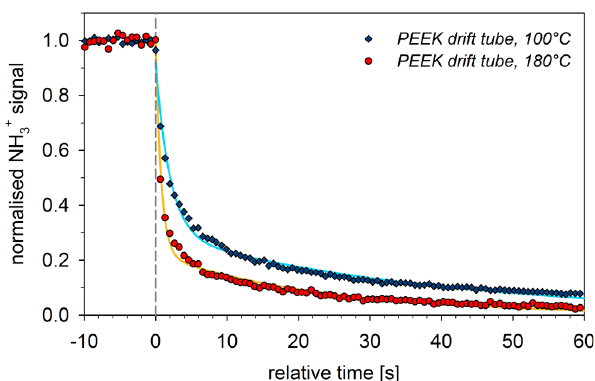
Fig. 4. Improvement of HT-CIMS time response by heating of the new prototype PEEK drift tube: switch from ∼ 150ppb to 0ppbNH 3 ; symbols show measurement data and solid lines rep- resent the respective fits according to Eq. 5.